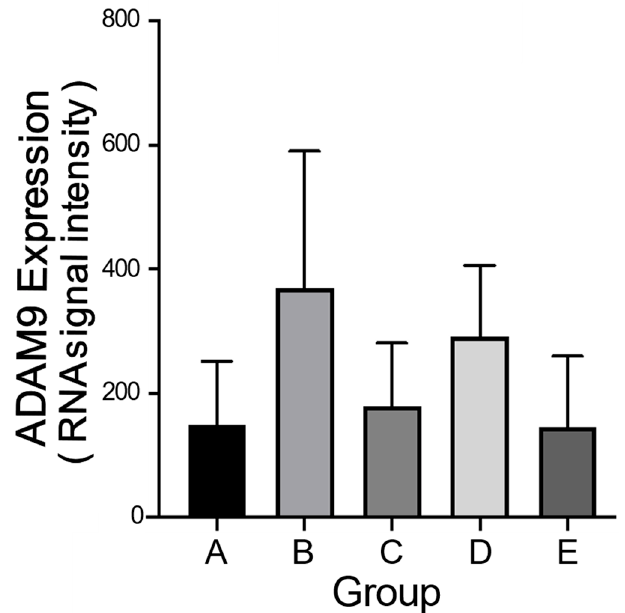
Figure 7. ADAM9 expression in five cancer types. The expression of ADAM9 in Group B (n = 13) was significantly higher than that in Group A (n = 14) and C (n = 15), and that in Group D (n = 13) was significantly higher than those in Group A and E (n = 5) ( p < 0.001).